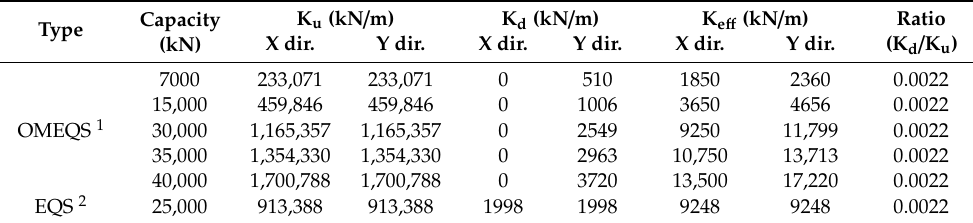
Figure 2. Subject bridge plan and installation configuration of base isolators. ( a ) The Nakdong river bridge plan; ( b ) Installation configuration of isolation systems. Table 2. Design parameters of resilient friction base isolators in testing